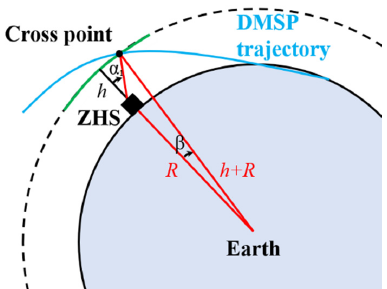
Figure 7. Diagram used for calculating the viewing zenith angle corresponding to the cross point.